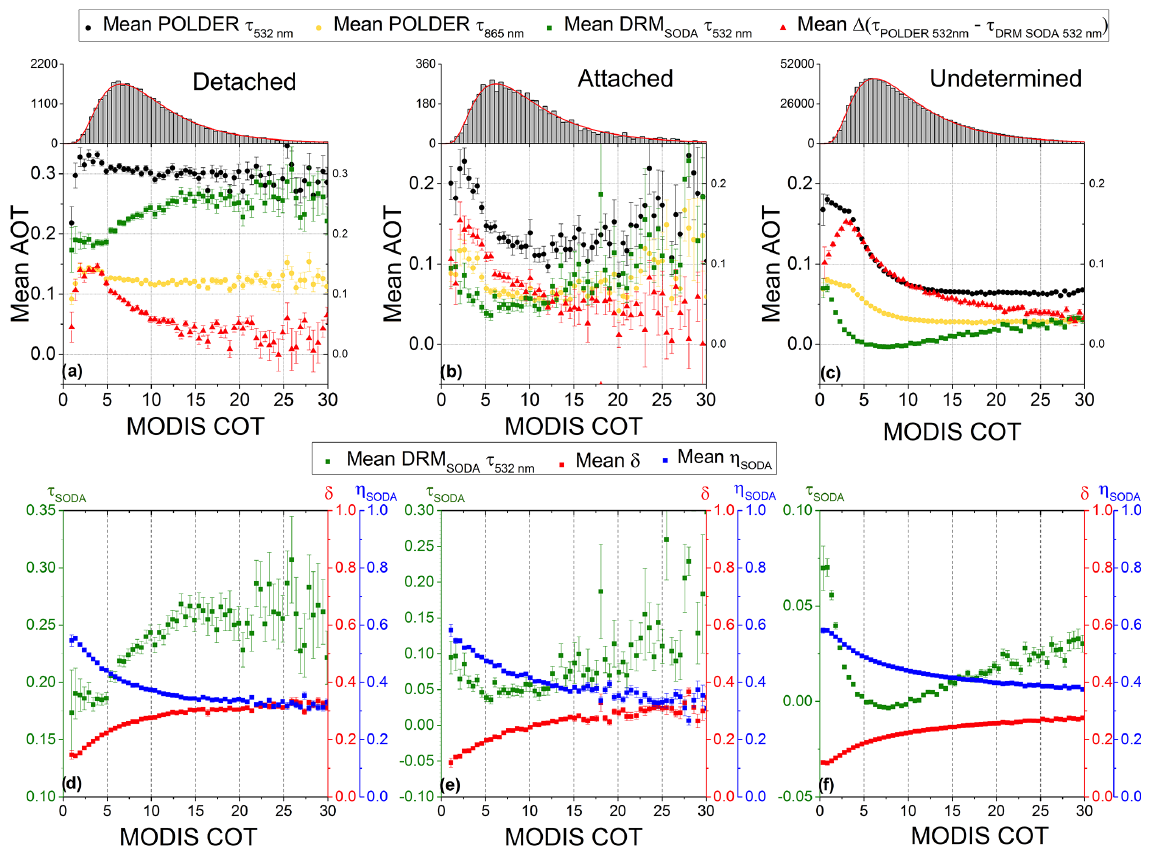
Figure 8. Four and a half years of global study of the evolution of POLDER and DRM SODA above-cloud AOT retrievals, as well as the differ- ence of these two methods as a function of MODIS cloud optical thickness (COT), for situations where the aerosol layer is detached from the cloud top (a) , for cases where the aerosol layer is attached to the cloud top (b) and for undetermined situations (c) . The histograms represent the distribution of COT. The error bars show the standard error of the mean (SEM). Panels (d) – (f) display the evolution of DRM SODA AOT ( τ SODA ) , depolarization ratio ( δ) and multiple scattering factor ( η SODA ) as a function of MODIS COT, for the abovementioned